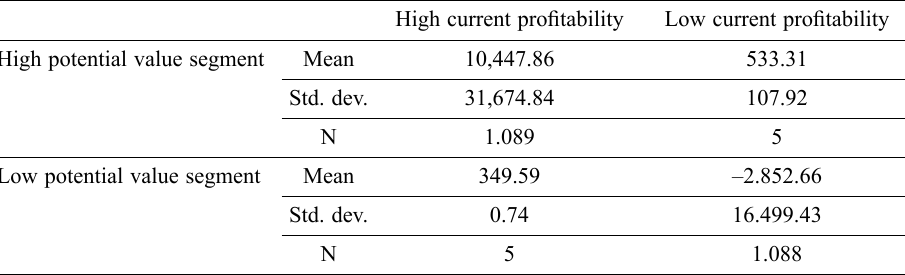
Table 7. Ex-post segmentation based on current profit and CPV (descriptive statistics calculated for CPV) High current